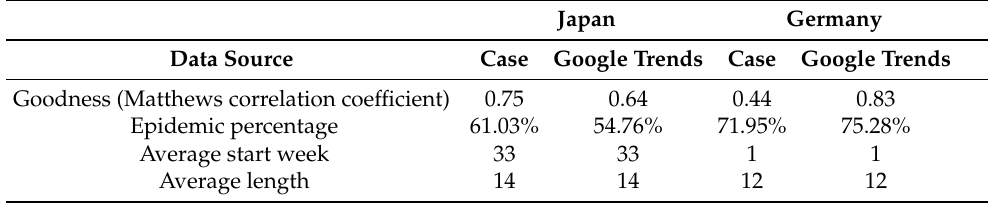
Table 1. Epidemic estimates of Japan 2015–2020 using MEM: identical epidemic seasonal start time and length were obtained by applying MEM over Google Trends and case